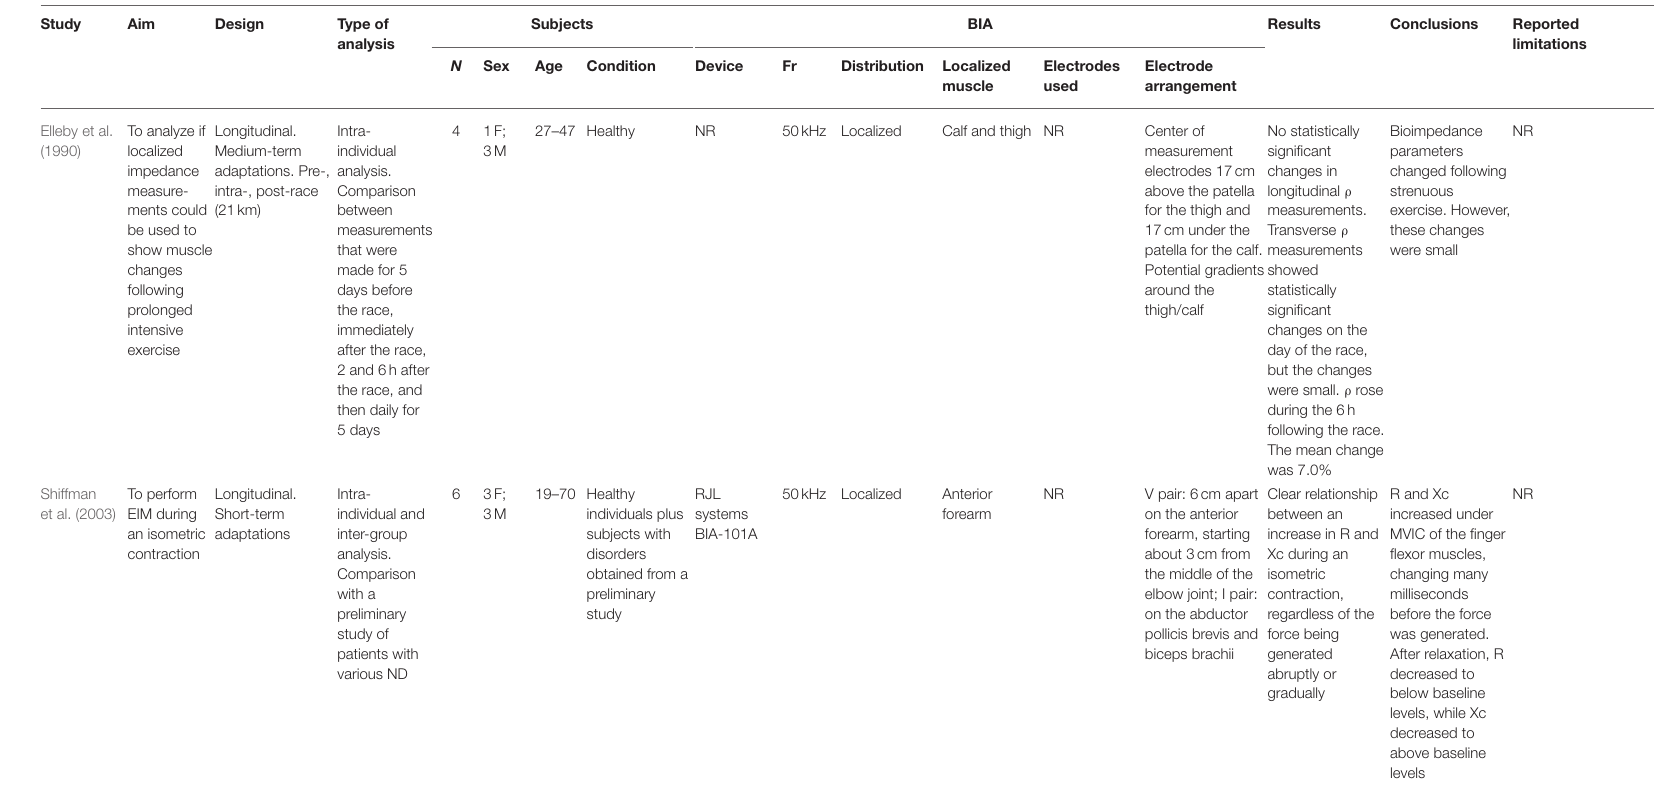
TABLE 3 | EIM studies analyzing adaptations to physical exercise.